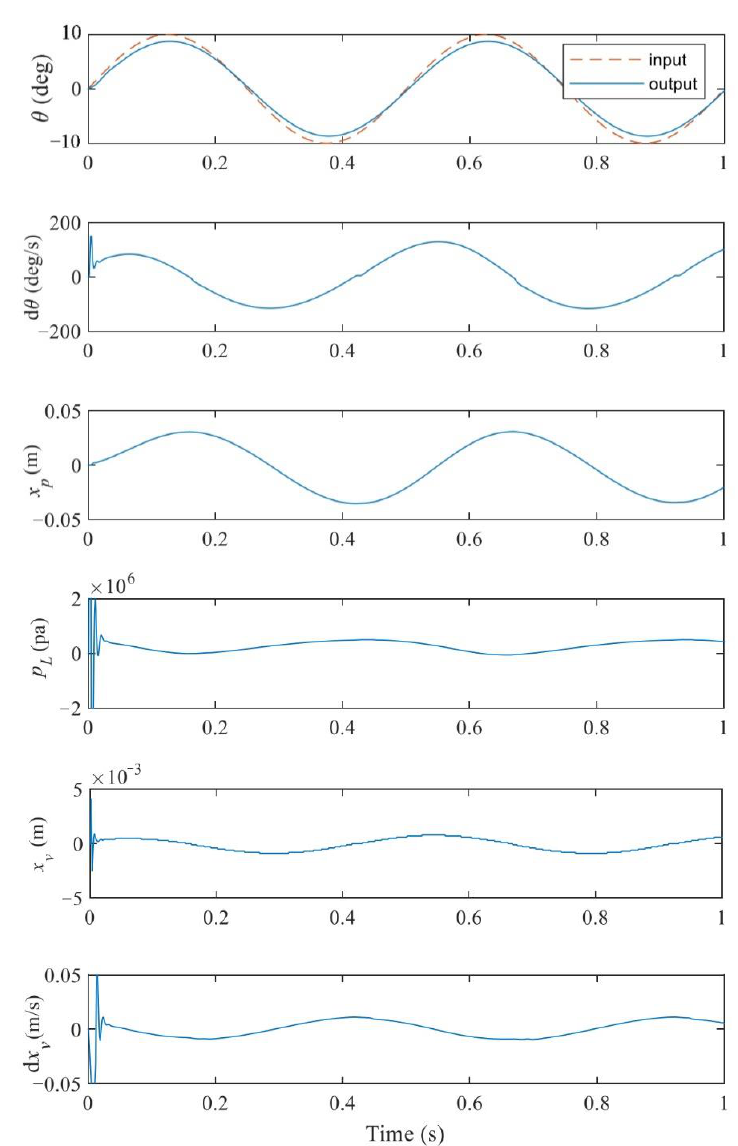
Figure 13. Backstepping HIL simulation curve (first set of control parameters).